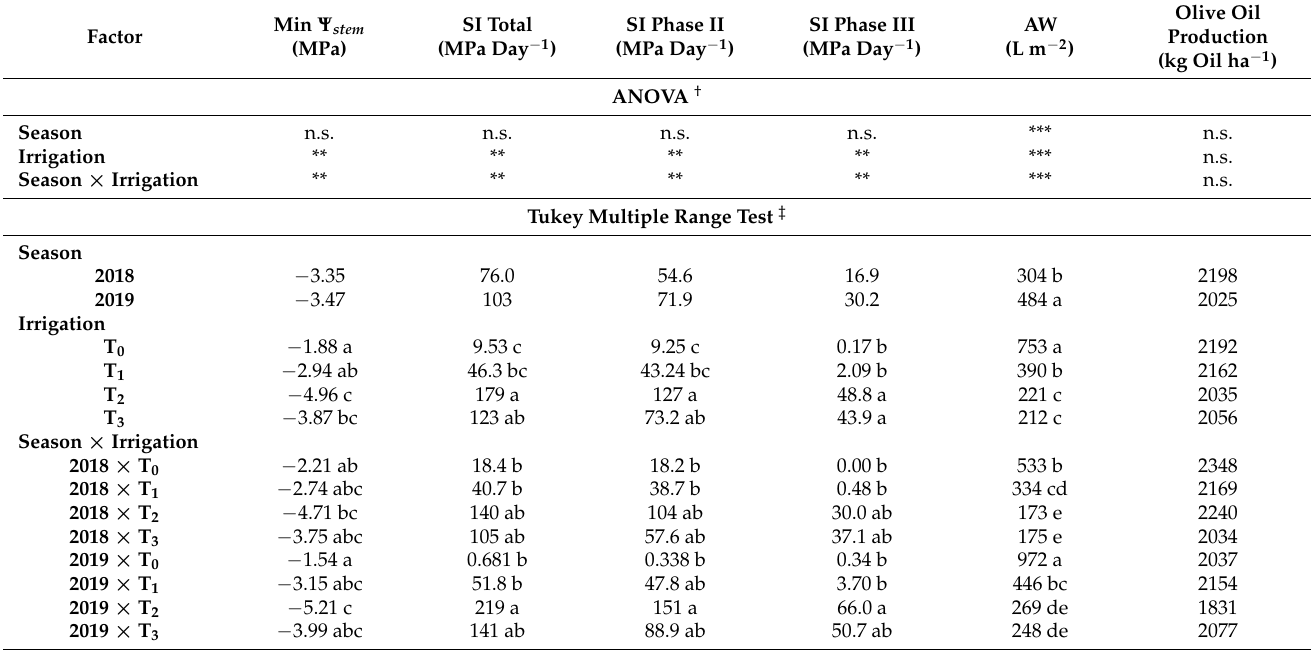
Table 1. Effect of the season (2018 and 2019) and irrigation treatment (T 0 , T 1 , T 2 and T 3 ) on minimum stem water potential (min Ψ stem ), water stress integral ( SI , MPa day − 1 ), applied water ( AW , L m − 2 ) and olive oil production in each deficit irrigation treatment during pit hardening in a super-high- density ‘Arbequina’ olive tree